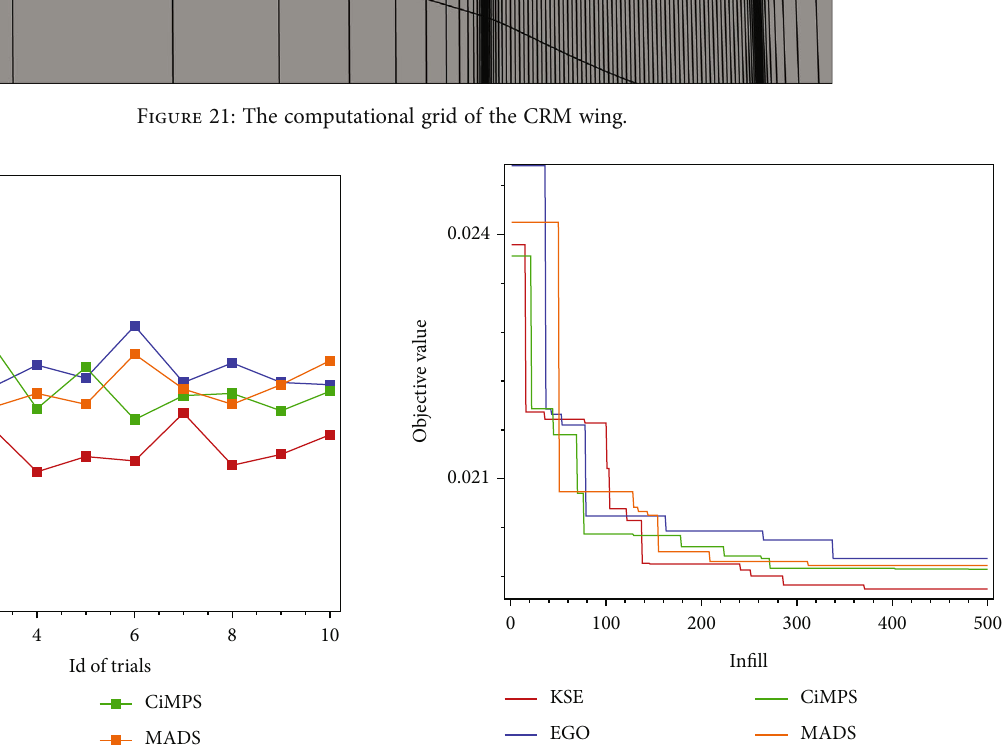
Figure 22: The results of ten trials of each method. Figure 23: Mean convergence of best objective function values in 10